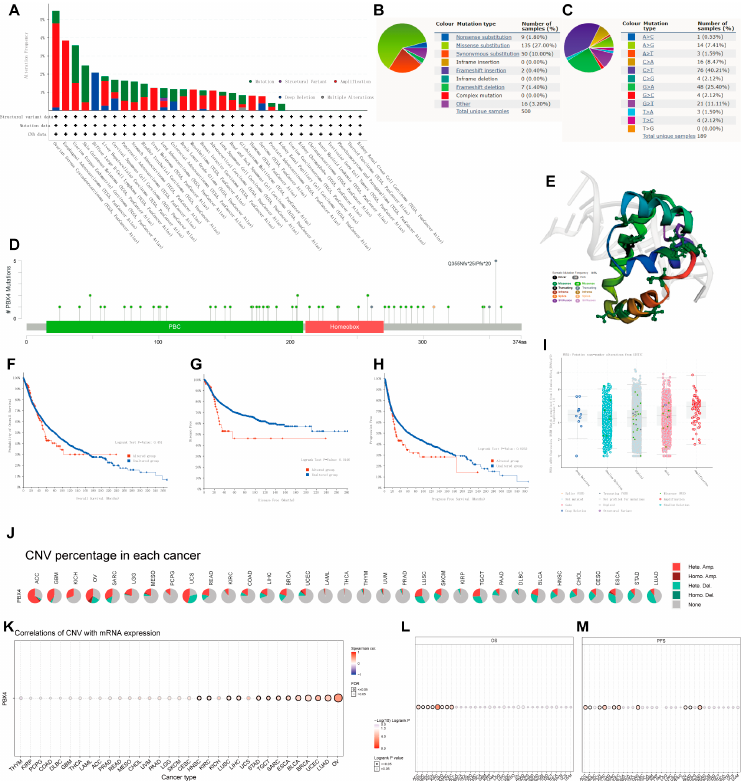
Figure 7. Mutation features of PBX4 in different human cancers. Overview of the mutation status of PBX4 across TCGA cancers by ( A ) cBioPortal and ( B ) COSMIC. ( C ) Summary of PBX4 substitutional mutation types by COSMIC. ( D ) Mutation sites and ( E ) corresponding 3D structures of PBX4 dis- played by cBioPortal. The correlations between pan-cancer PBX4 mutation status and ( F ) OS, ( G ) DFS, and ( H ) PFS by cBioPortal. ( I ) The putative CNA of PBX4 from the GISTIC database. ( J ) Sum- mary of PBX4’s CNV across TCGA cancers and ( K ) the correlation between PBX4 expression and CNV in different cancers by GSCA. The difference of ( L ) OS and ( M ) PFS between PBX4’s CNV and wide type in different cancers by GSCA.